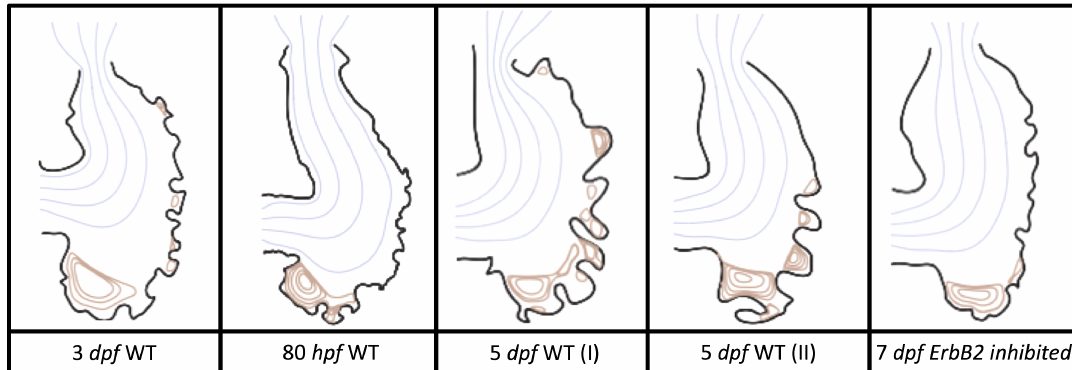
Figure 5. Streamlines showing the direction of steady flow through realistic trabeculated ventricular geometries for the biologically relevant Re , Re = 1. The orange lines detail closed streamlines, illustrating vortical flow patterns, while blue laminar, non-vortical flow